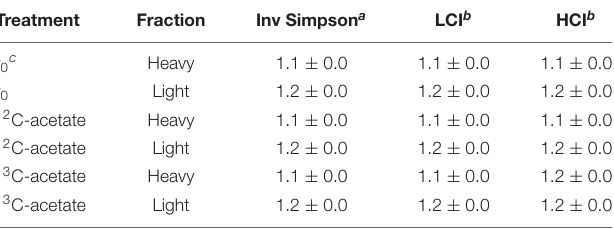
TABLE 4 | Inverse Simpson values for archaeal 16S rRNA amplicon sequences. Mean values of biological replicates with standard deviation.